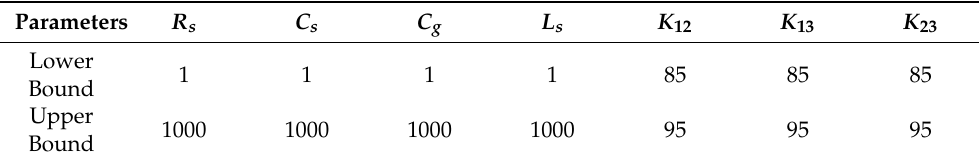
Table 2. Parameter Boundary